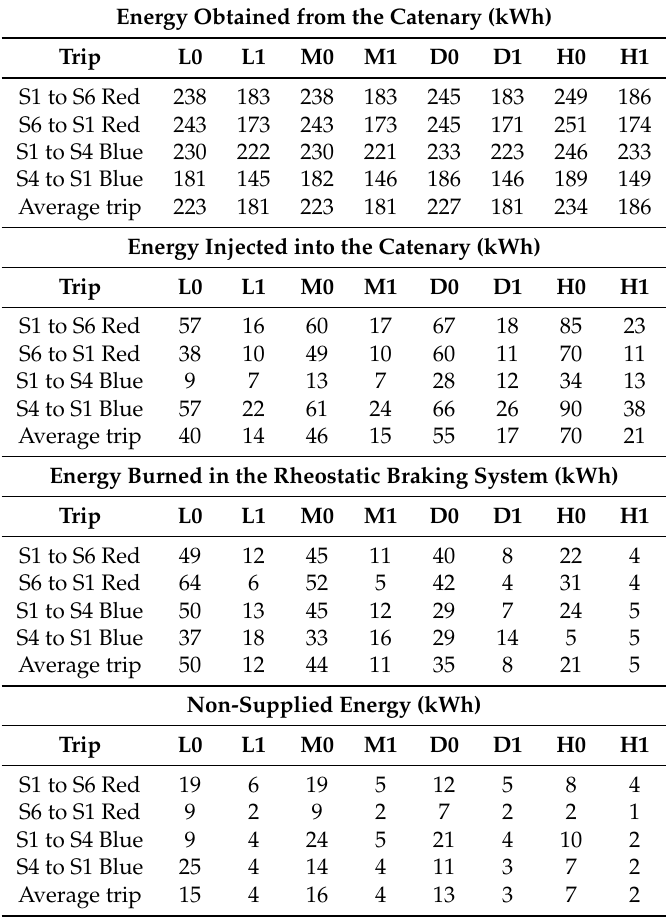
Table 6. Summary of the train behavior in the average trip for all lines and in all scenarios.